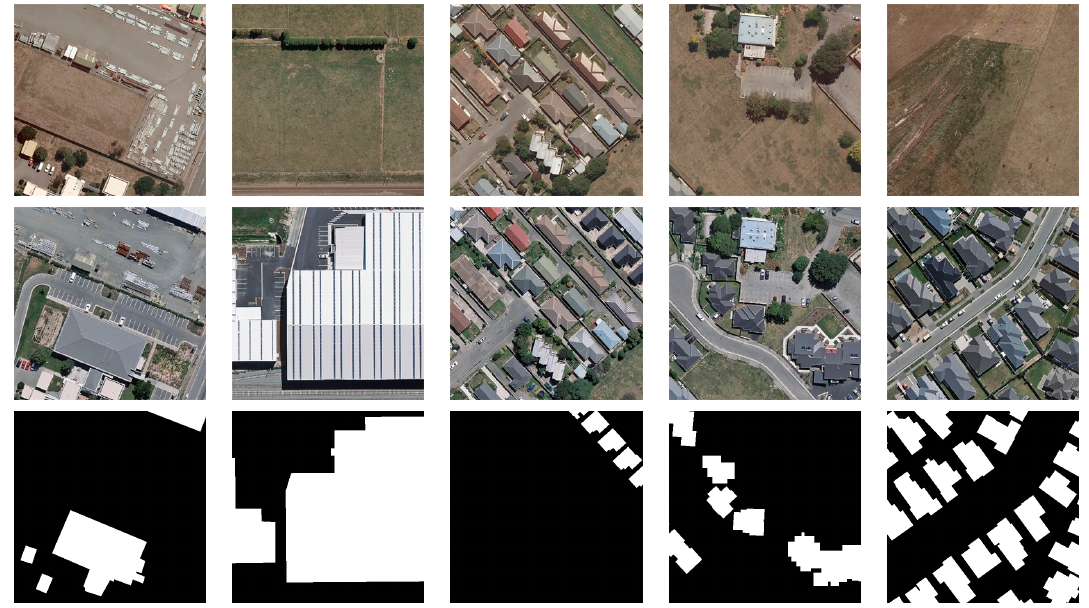
Figure 8. Examples of changed buildings. The top row is images of 2011, middle row is images of 2016 and bottom row is the change labels.